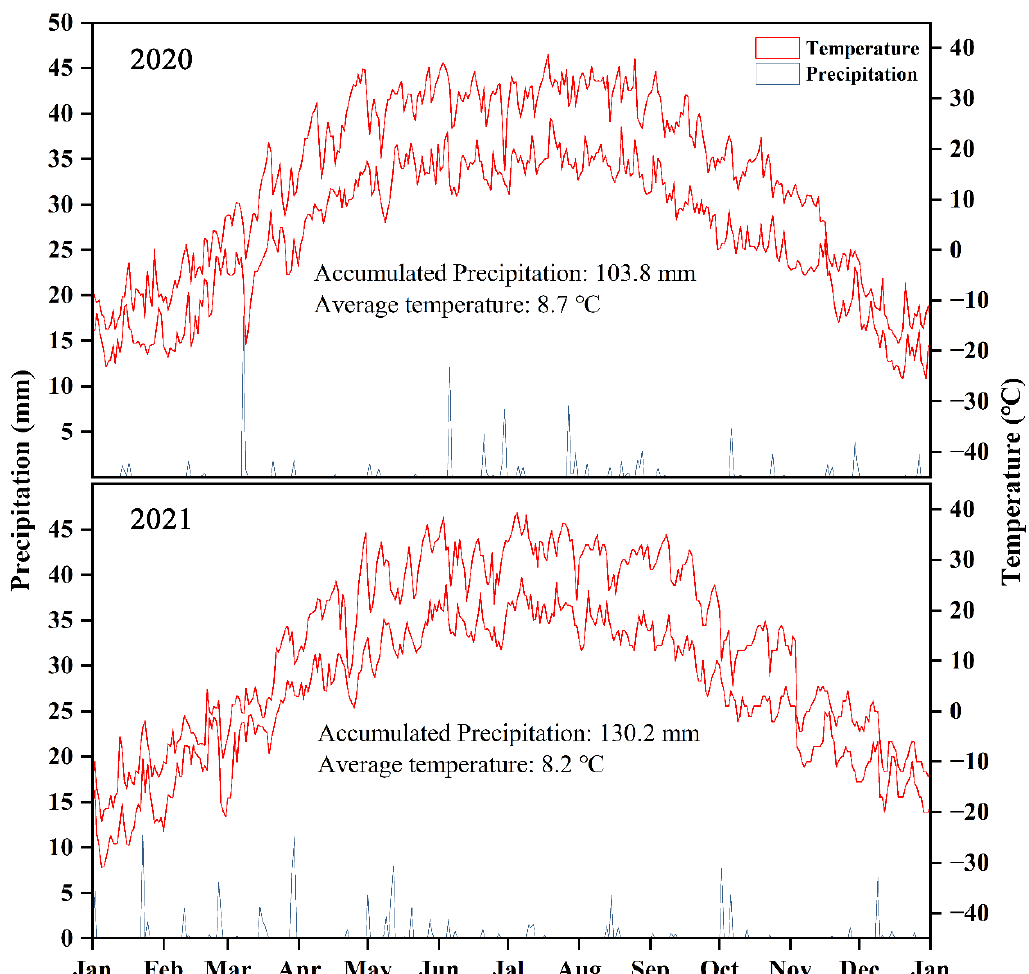
Figure 1. Climate data during the experimental period.